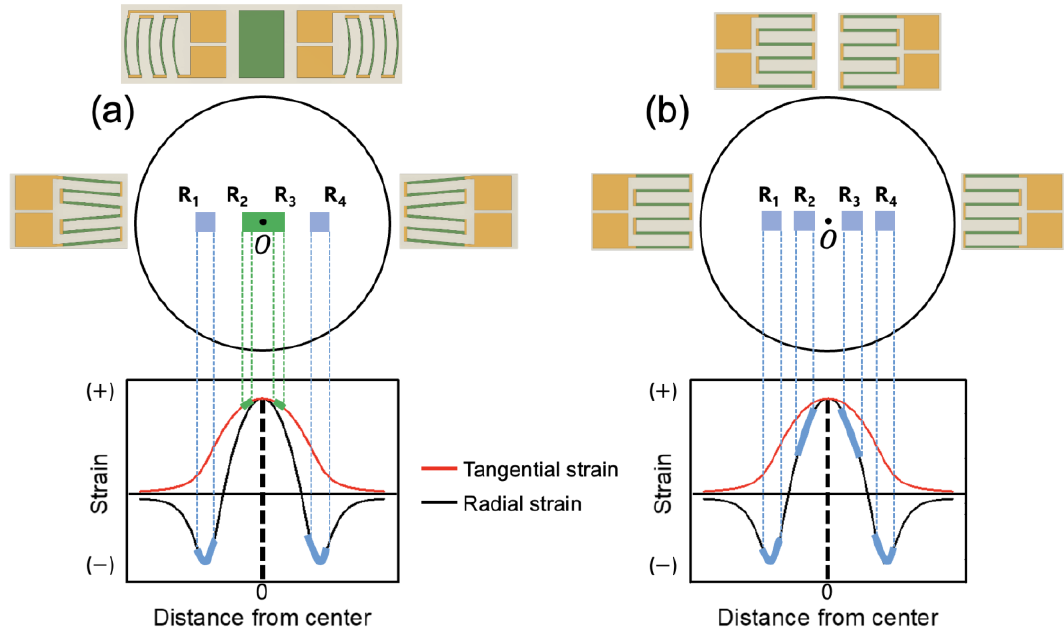
Figure 12. Installation positions of strain gauges on the circular diaphragm in two types of bridge configurations. ( a ) Full-bridge configuration consisting of newly designed three-gauge chips; ( b ) conventional bridge consisting of four single-gauge chips.